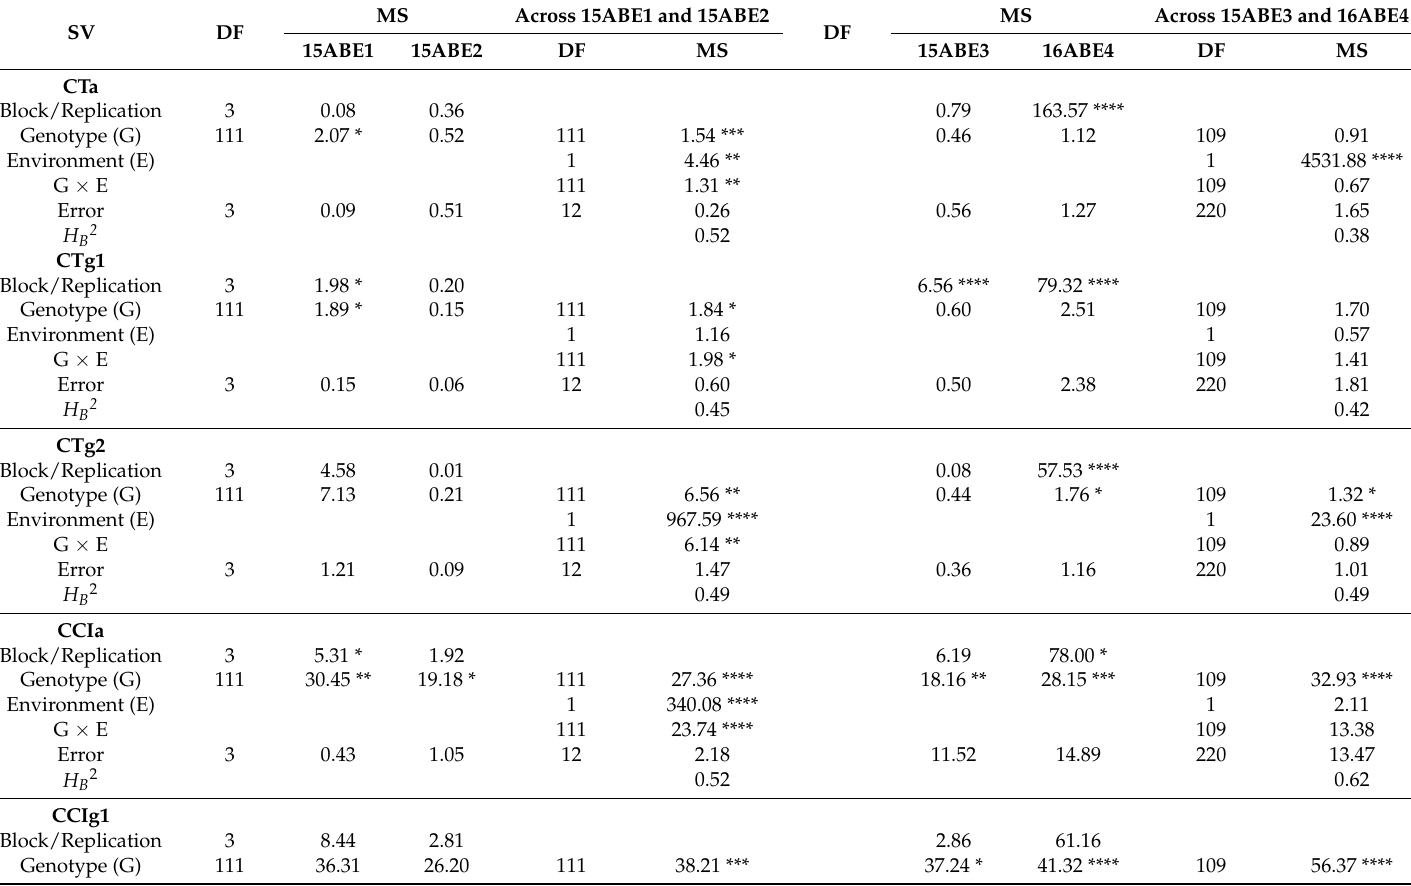
Table 2. Analysis of variance (ANOVA) and broad-sense heritability ( H B2 ) for the traits measured in four environments (110 doubled haploid (DH) lines and two cultivar checks in 15ABE1 and 15ABE2, two replications in 15ABE3 and